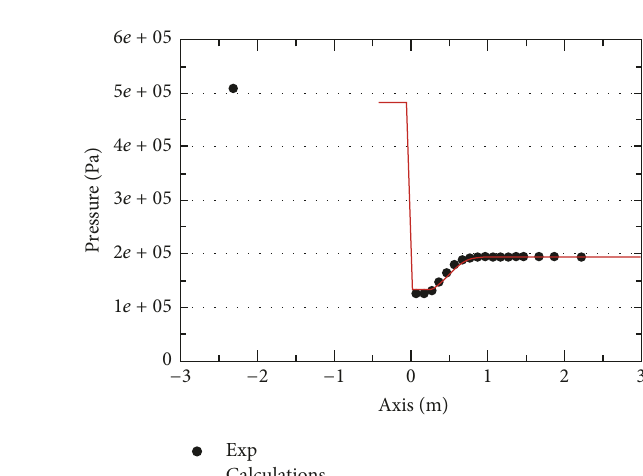
Figure 72: Lady 18